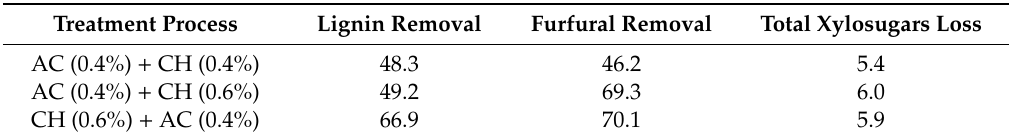
Table 3. E ff ect of combined treatment sequences of AC and CH on lignin and furfural removal and total xylosugars loss (%).